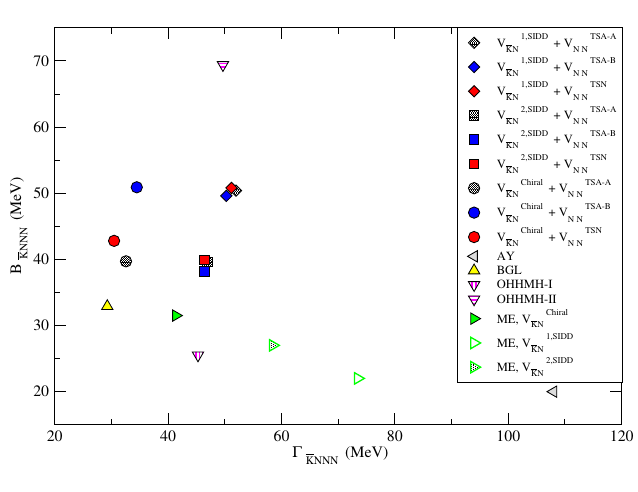
Γ Figure 1. Binding energies B ¯ ¯ KNNN (MeV) of the quasi-bound state of the KNNN (MeV) and widths ¯ KNNN state calculated using three di ff erent models of antikaon-nucleon interaction and three nucleon- nucleon models. The results of other authors are also